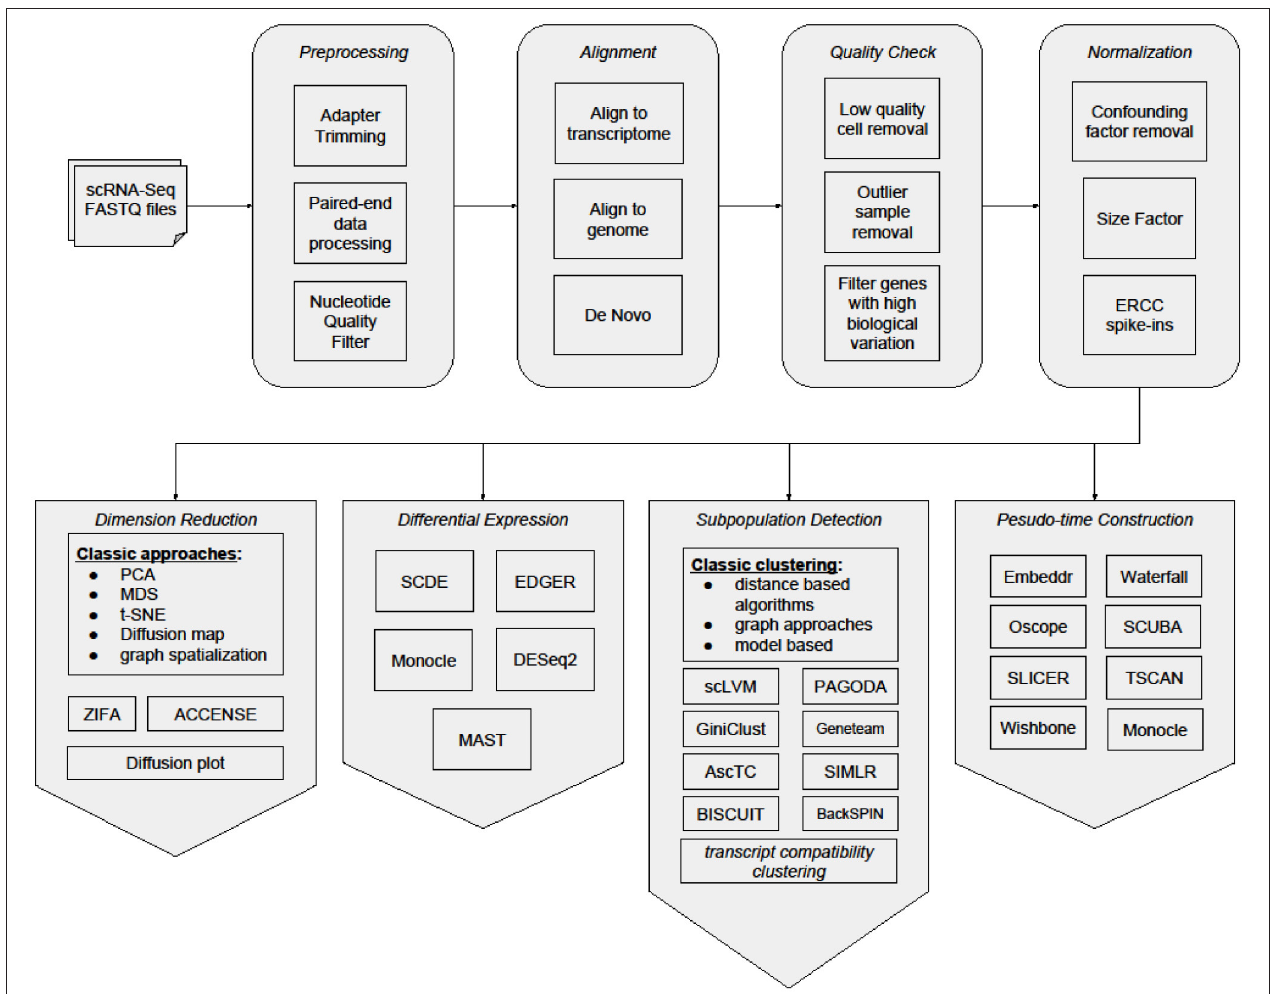
FIGURE 1 | General workflow of Single-cell